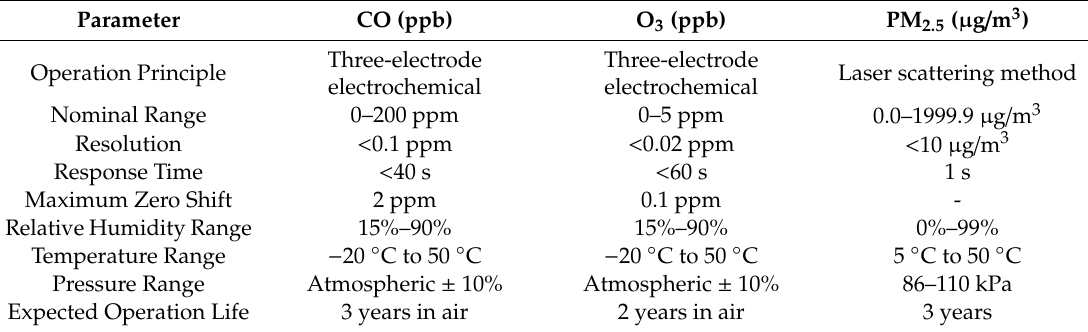
Table 1. Technical specifications and applied environmental conditions of the low-cost air quality